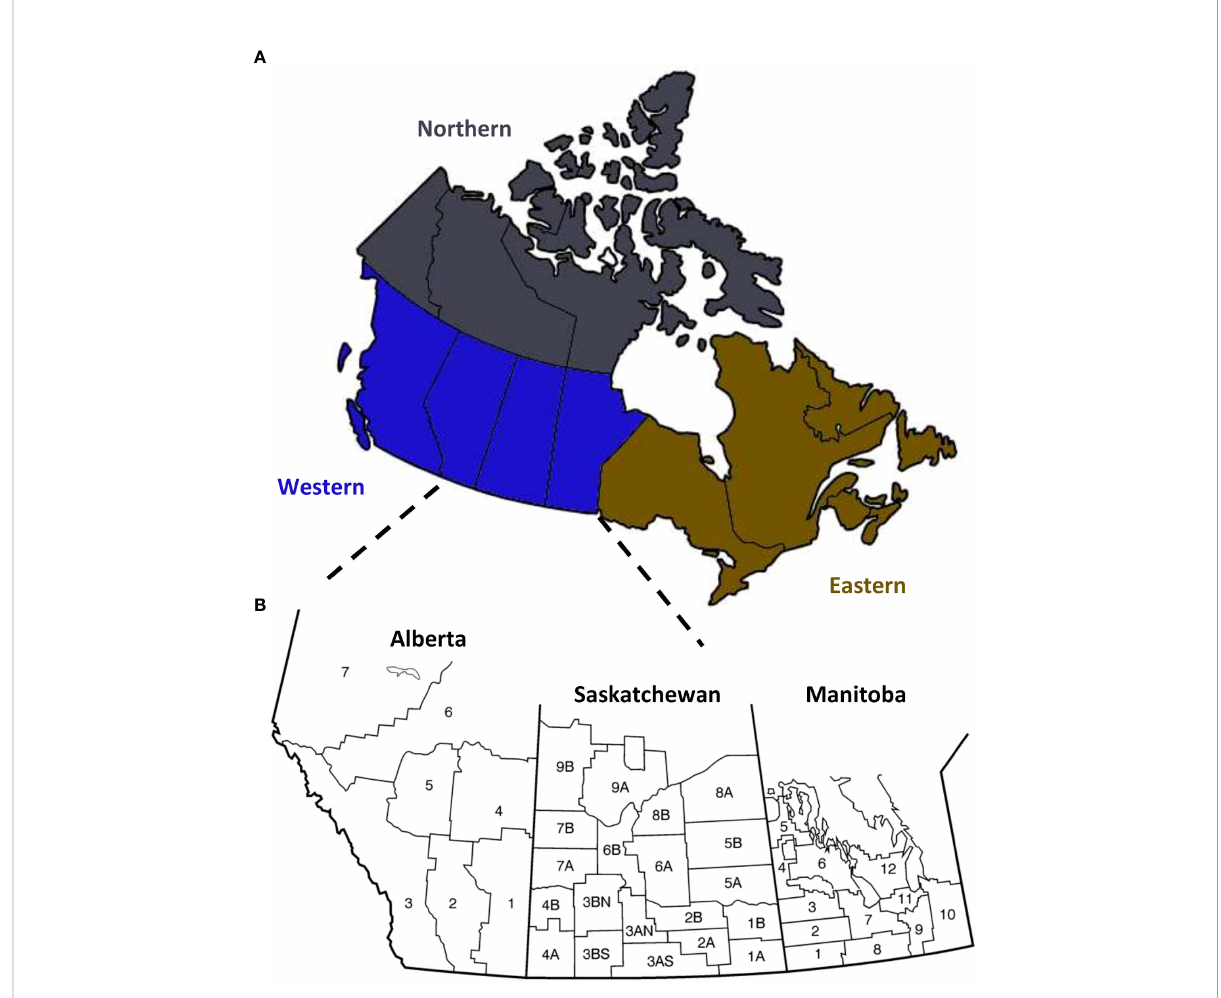
FIGURE 1 Map of Canada. (A) Wheat samples were obtained from western (blue) and eastern (gold) Canada. (B) Most of the samples were from the western Canadian provinces of Alberta, Saskatchewan, and Manitoba, which are organized into different crop districts based on growing conditions and